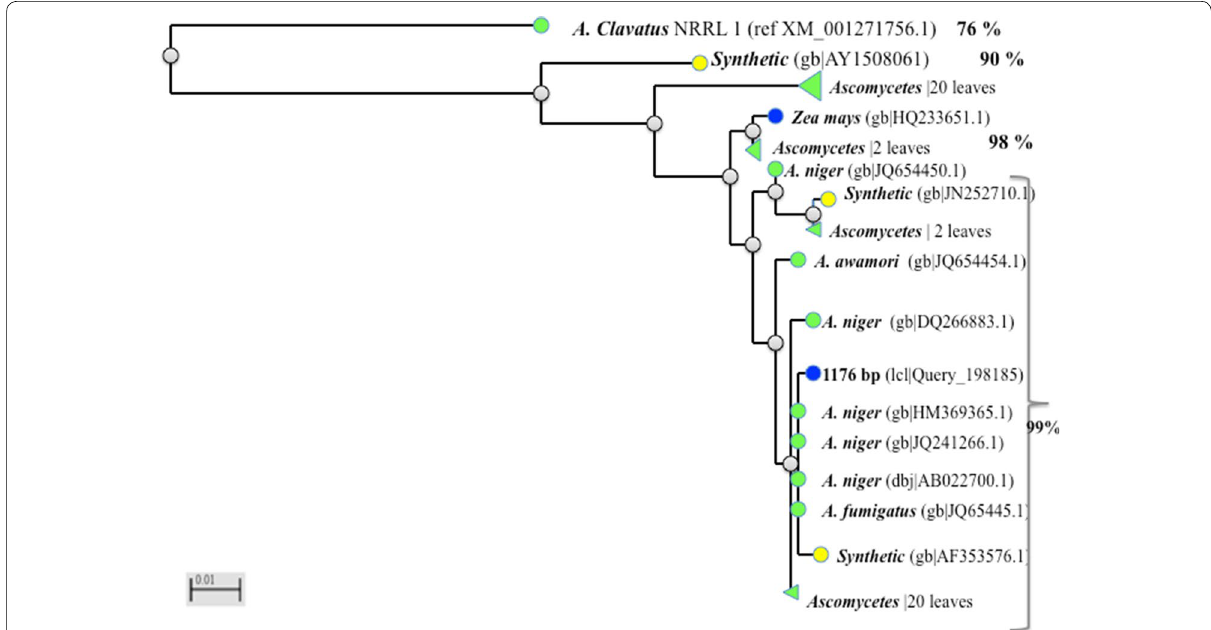
Fig. 6 Phylogenetic relationship of 1176 bp cloned partial phytase gene complementary DNA sequences of Aspergillus foetidus MTCC 11682 with different other close by species and synthetic sequences. Relationship tree was constructed by neighbourhood joining method using NCBI Blast tree view software with default setting. The percentage similarity of sequences is given to the right